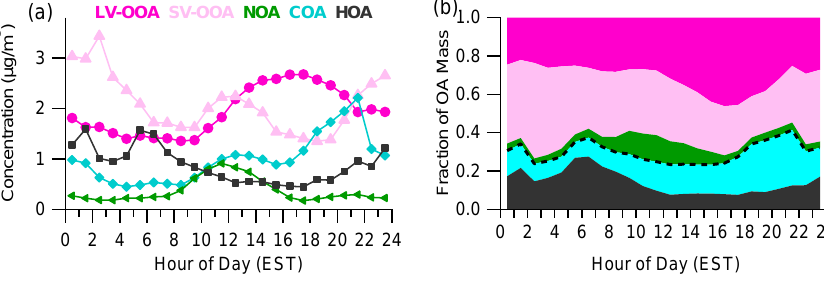
Fig. 13. Diurnal cycles of (a) mass concentrations and (b) mass fractions of five OA components. The dash line in (b) shows the mass fraction of POA